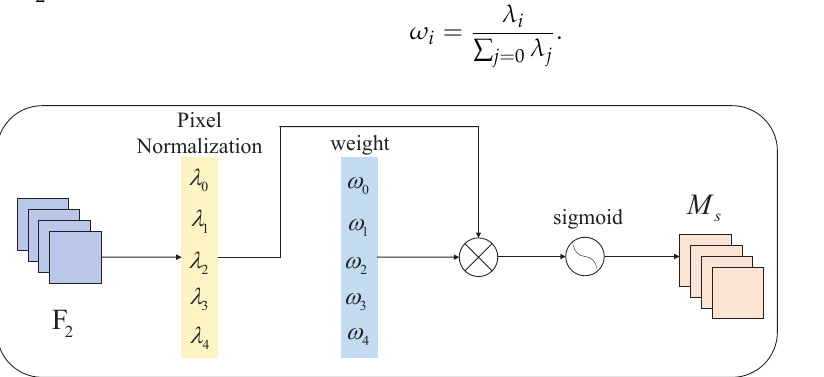
Figure 7. Spatial attention submodule of